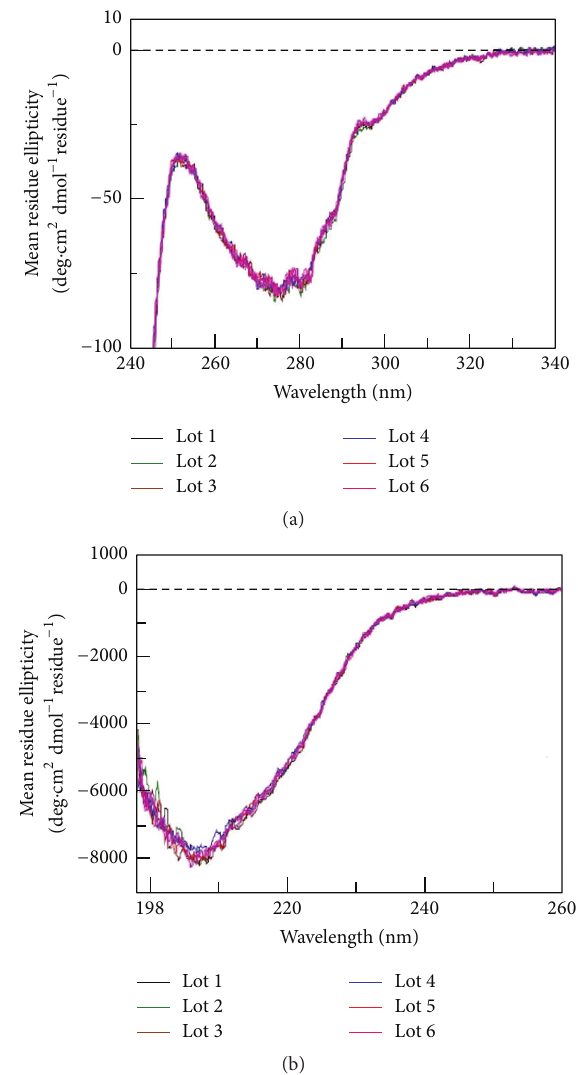
Figure 3: Circular dichroism spectroscopy was carried out in 25 mM MOPS, 150 mM NaClO 4 , 5 mM CaCl 2 , and pH 7.5 at approx- imately 1.0 mgmL −1 factor IX. CD measurements were carried out with a 1cm cell for near UV measurements and a 0.02 cm cell for far UV measurements. Five accumulations were obtained per spectrum. The spectrum of the buffer blank was subtracted from the sample spectra; then the observed ellipticities were converted to mean residue ellipticities using the protein concentration, the mean residue weight (112.2Da), and the path length of the cell. Near UV spectra are shown in the upper panel. Far UV spectra are shown in the lower panel. The spectra from six trenonacog alfa lots are shown on each